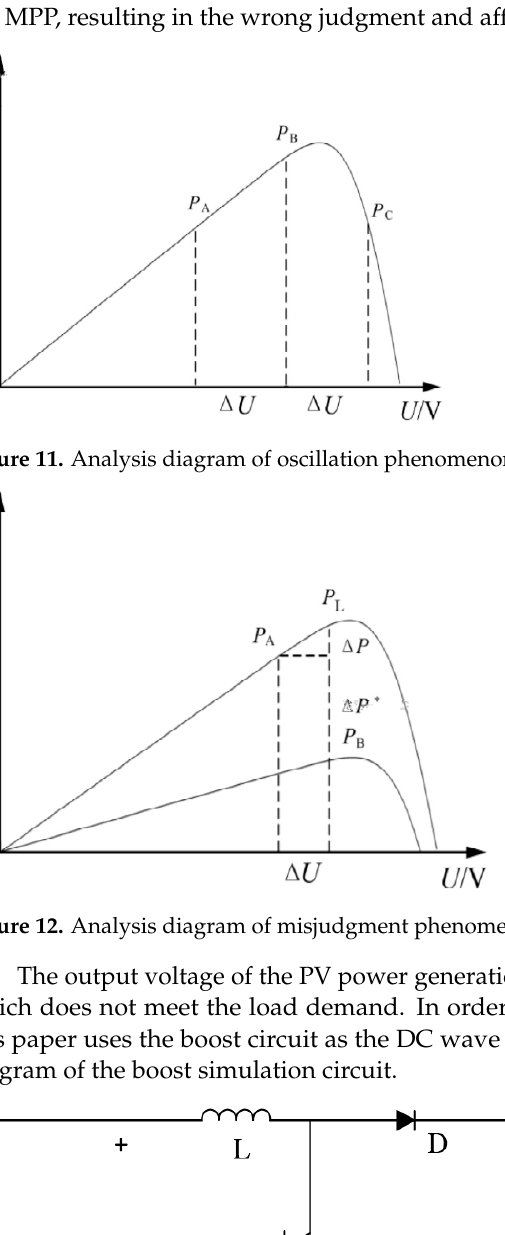
Figure 11. Analysis diagram of oscillation phenomenon.